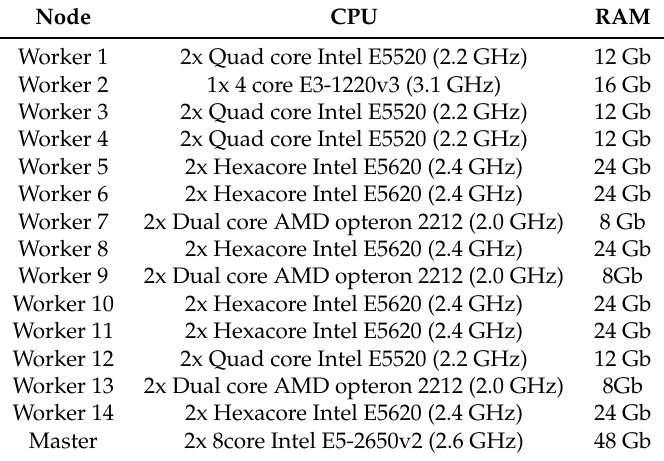
Table 2. The Hardware Configuration of each Cluster Node.